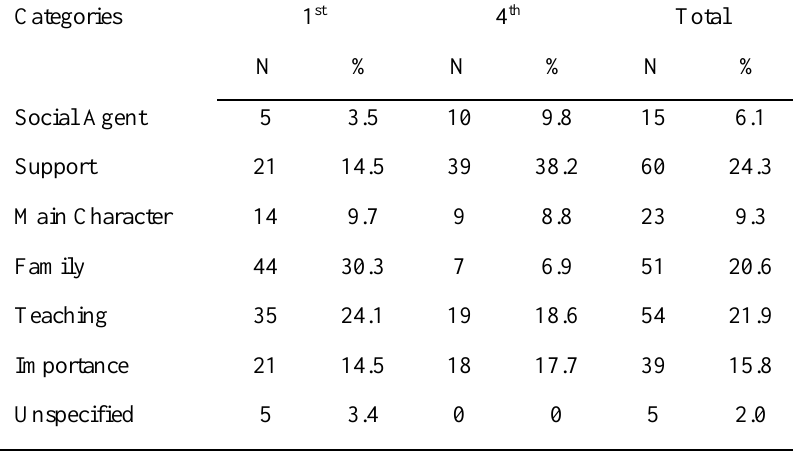
Frequencies and percentages of answers in each category in 1 st and 4 th years